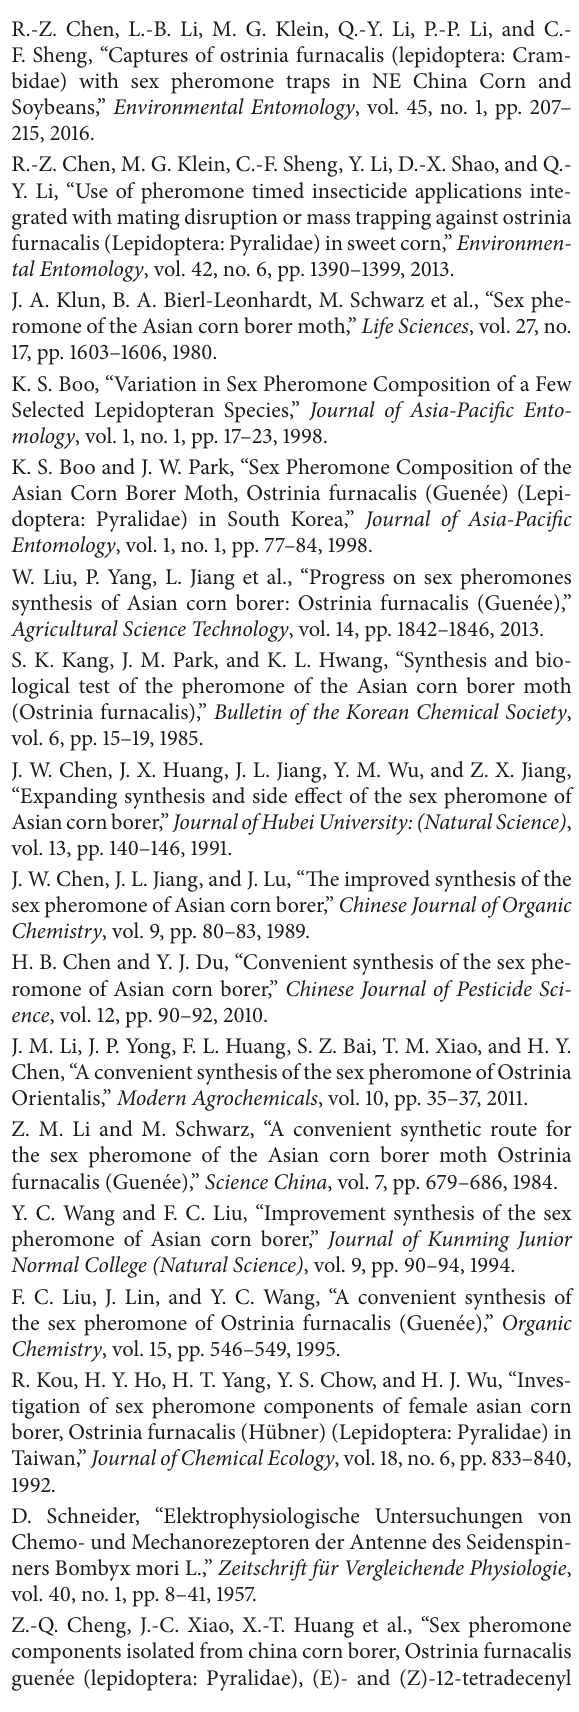
[22]. Table 1: retention time of the gonad extract of Asian Corn Borer [22]. Figure B: GC-MS analysis of the sex phe- romone of Asian Corn Borer. Table 2: retention time of the sex pheromone of Asian Core Borer. (Supplementary